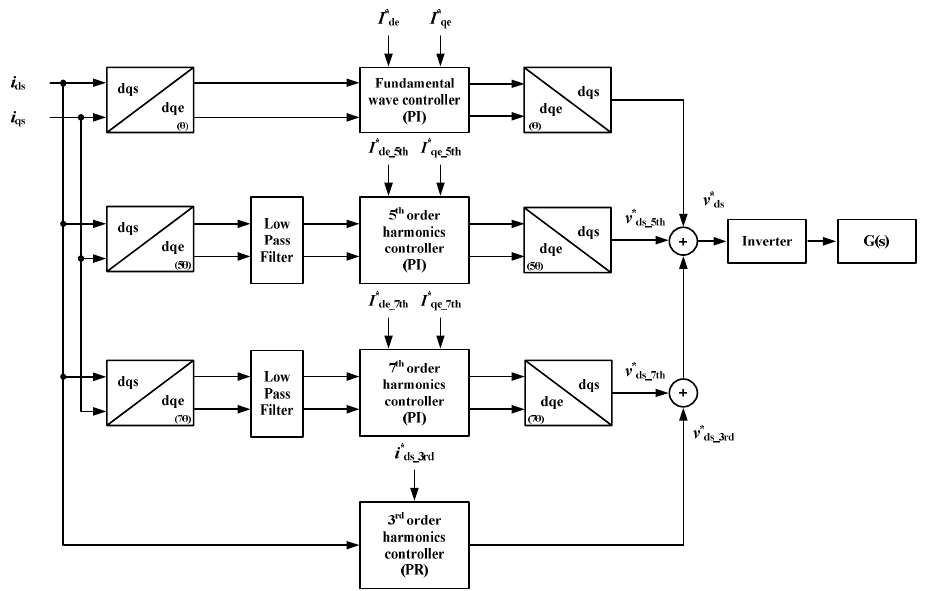
Figure 7. Block diagram for lower-order harmonics compensation method.